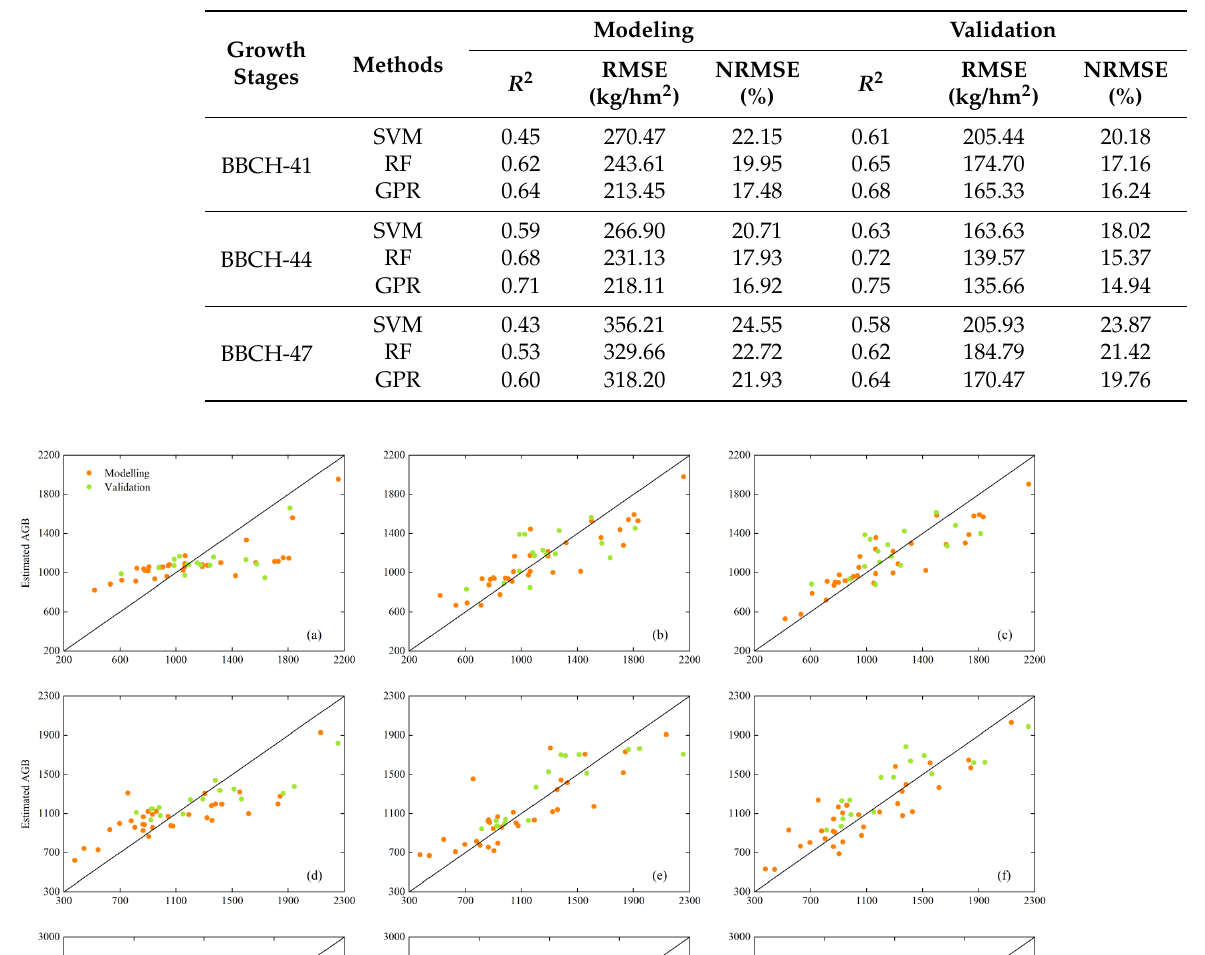
Table 7. Potato AGB estimates based on selected VIs for each growth stage.